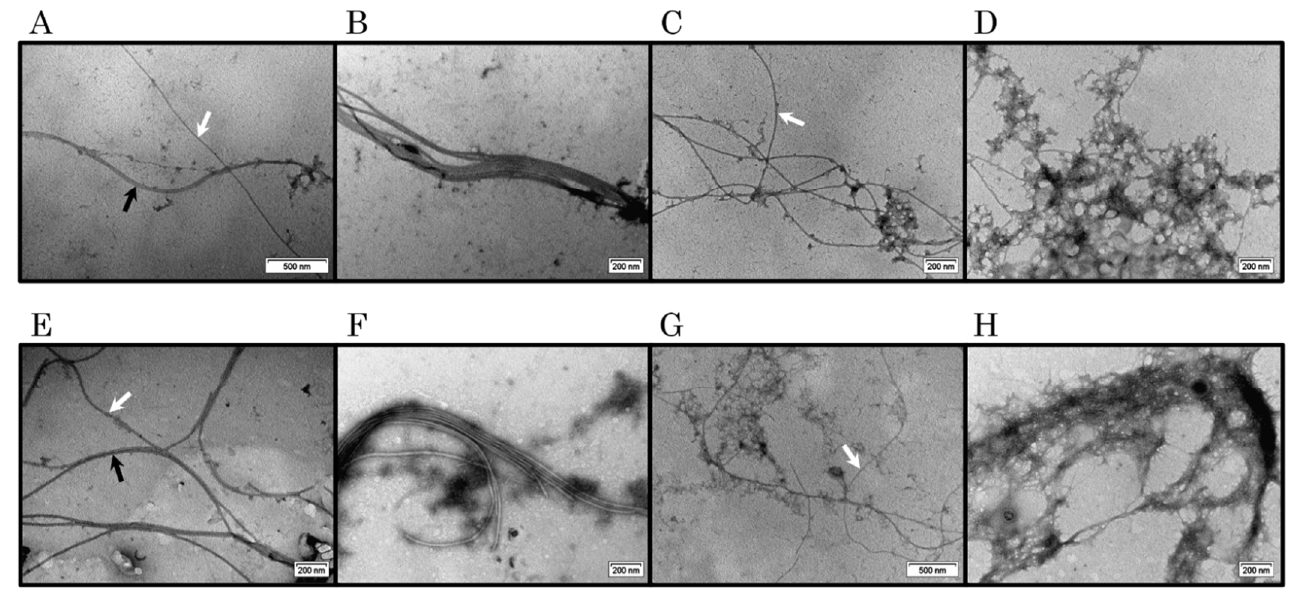
Figure 7. Negatively stained TEM micrographs of ( A – D ) C ‐ TERb and ( E – H ) C ‐ TERa incubated for 144 h (6 days) in TBS at ~20 °C (C C ‐ TER = 10 μ M). The two C ‐ TER isoforms show a similar morphologic diversity. ( A , E ) Long single straight (SSFs) (indicated by the white arrows) and double straight fibrils (DSFs) (indicated by the black arrows). ( B , F ) Such SSFs and DSFs tend also to densely pack into multiple straight fibrils (MSFs). ( C , G ) SSFs (indicated by the white arrows) can be found in extended and diffuse networks of intersecting filaments. ( D , H ) Amorphous aggregates are also observed. The scale bar is provided at the bottom right of each TEM micrograph.